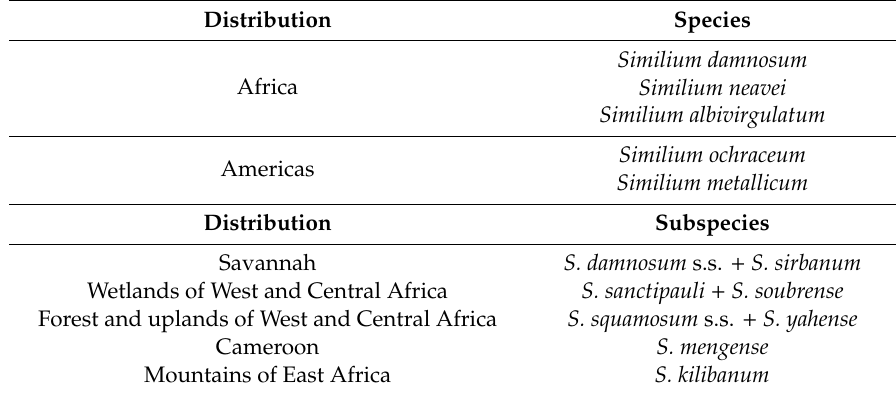
Table 1. Distribution of black flies, vectors of Onchocerca volvulus , by continent and environment [31].